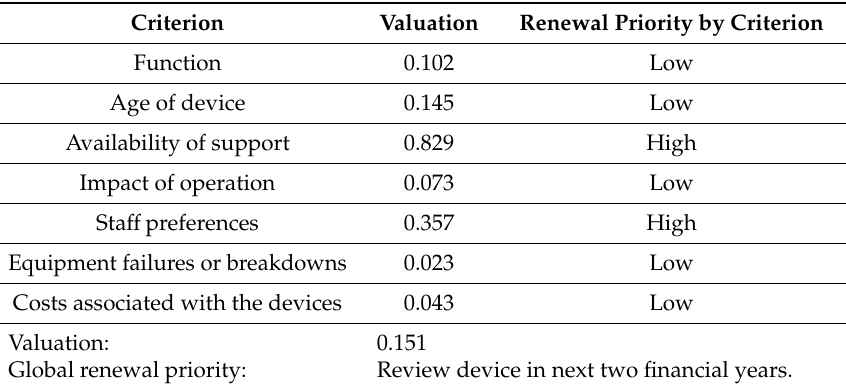
Table 28. Results for video colonoscope.